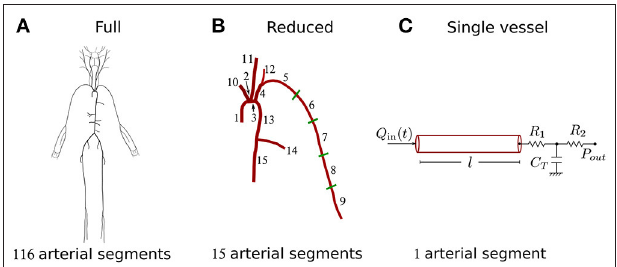
FIGURE 2 | Schematic representation of the three models used in the study. (A) Full 116-artery model with cardiovascular properties taken from Charlton et al. (2019). (B) Reduced 15-artery model containing the aortic-brachial arterial path of the full model. (C) Single-vessel model of the brachial artery with the nomenclature used throughout the study. Tapering in the brachial artery of the full and reduced models was represented by five straight arterial segments of different radii. The single-vessel model allowed us to identify analytically the main physical determinants of 1